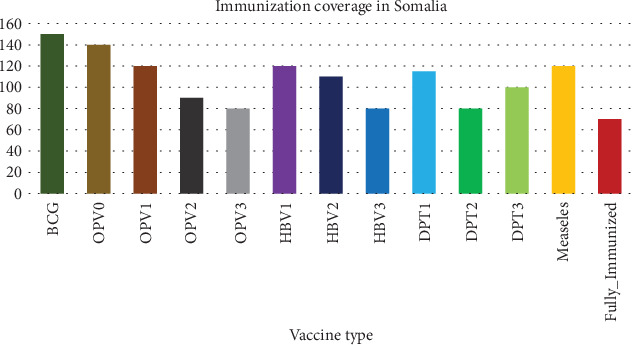
The immunization coverage of investigated children (11-24 months) in Somalia.